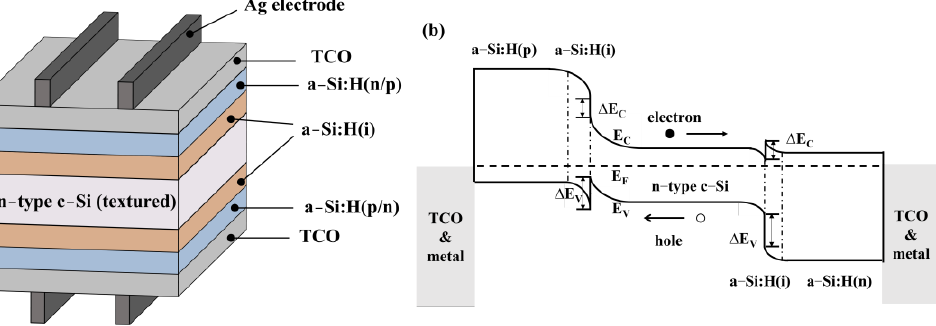
Figure 1. ( a ) A sketch of the structure of a SHJ solar cell made from the n − type c − Si substrate. ( b ) A schematic band diagram for heterojunction structure of n − type SHJ solar cell. The arrows point in the transport direction of electrons and holes. E F denotes the Fermi energy level. ∆E C and ∆E V stand for conduction band offset and valence band offset, respectively. The band bending at the a − Si:H/TCO interfaces is not drawn (for simplicity). For the front emitter and rear emitter solar cells, light is incident from the left and right sides, respectively.